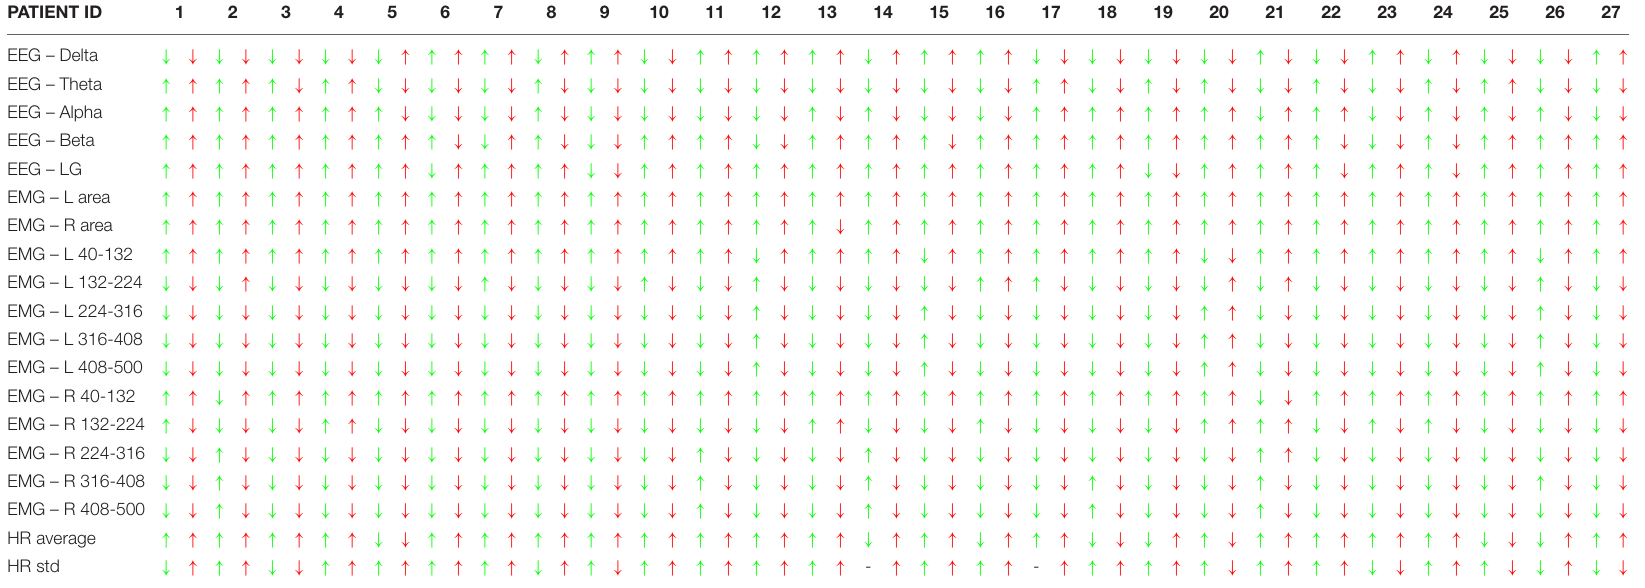
TABLE 2 | Difference of the objective brain, muscle, and health bio measurements between the first static protocol and the light (1 Hz – green) and the hard one (3 Hz – red) for all the patients (the one that did not perform the 3-Hz protocol is not included). PATIENT